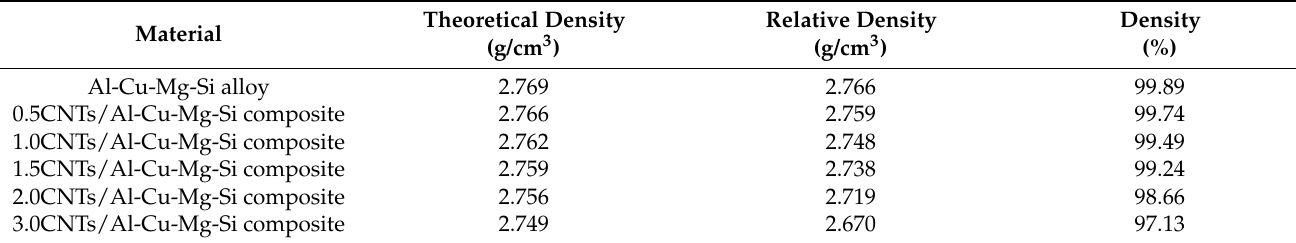
Table 3. The density of x CNTs/Al-Cu-Mg-Si composites.